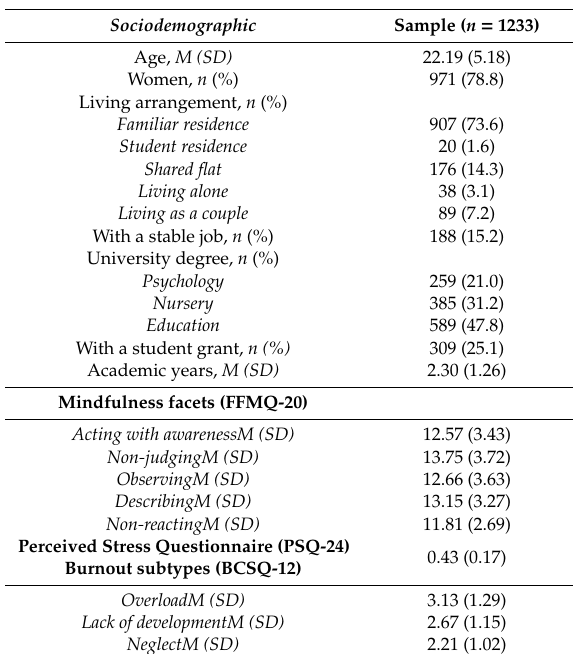
Table 1. Sociodemographic and outcome